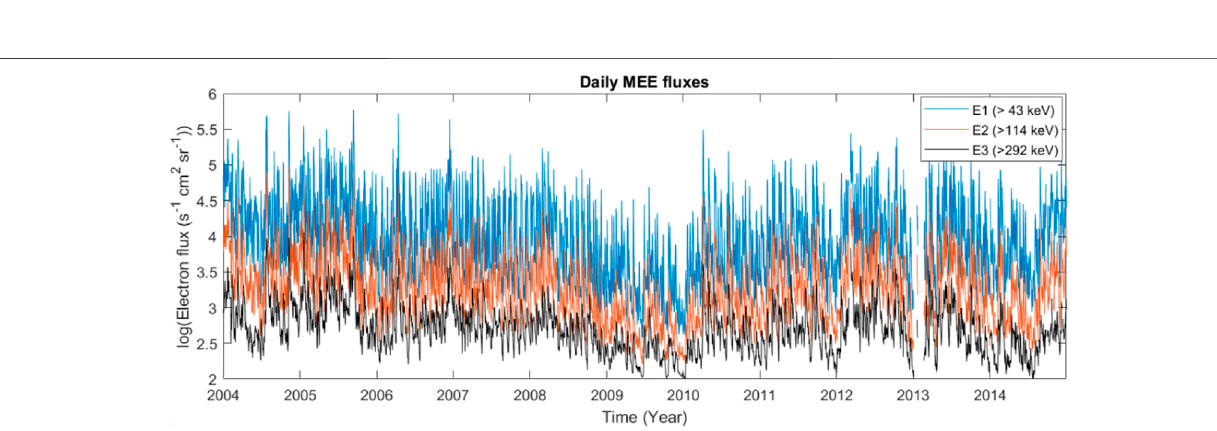
Frontiers in Astronomy and Space Sciences |